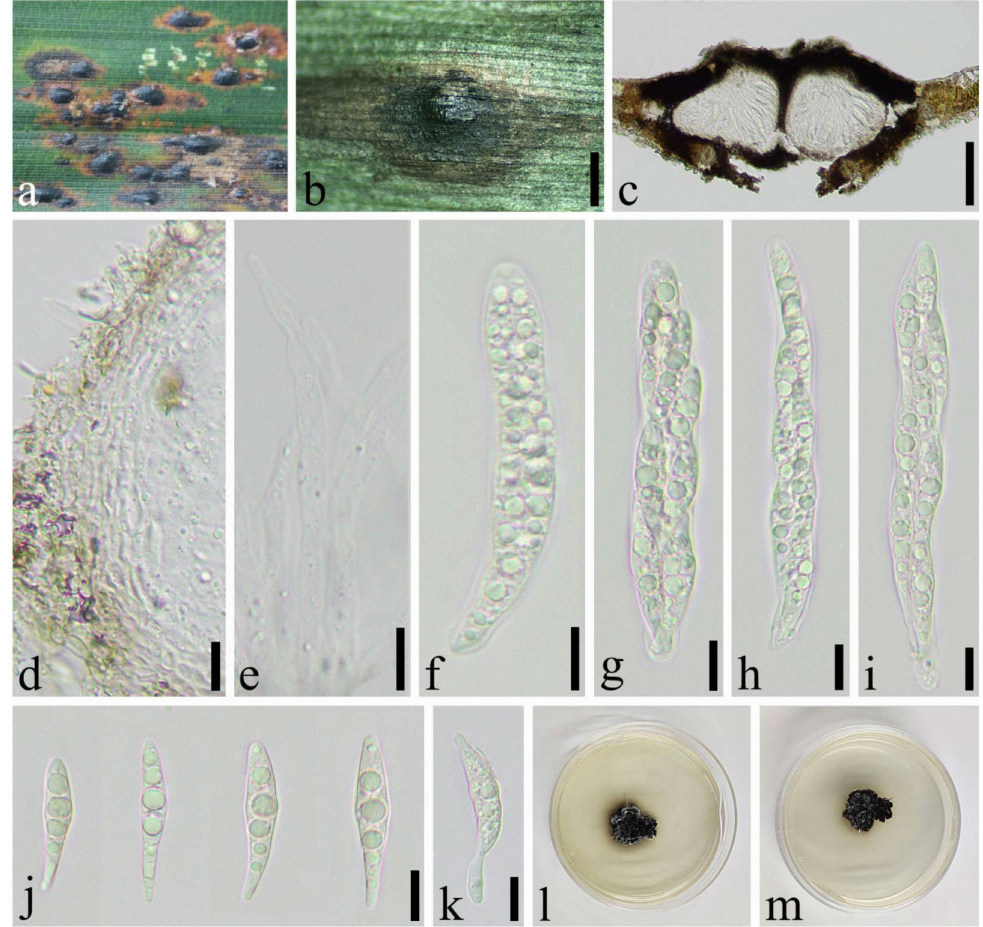
Figure 9. Bifusisporella sichuanensis (SICAU 22-0073). ( a , b ) Ascostromata developing on the host. ( c ) Vertical sections of ascostromata. ( d ) Peridium. ( e ) Pseudoparaphyses. ( f – i ) Asci. ( j ) Ascospores. ( k ) Germinating ascospore. ( l , m ) Cultures on PDA. Scale bars: ( b ) = 500 µ m, ( c ) = 100 µ m, ( d – k ) = 10 µ